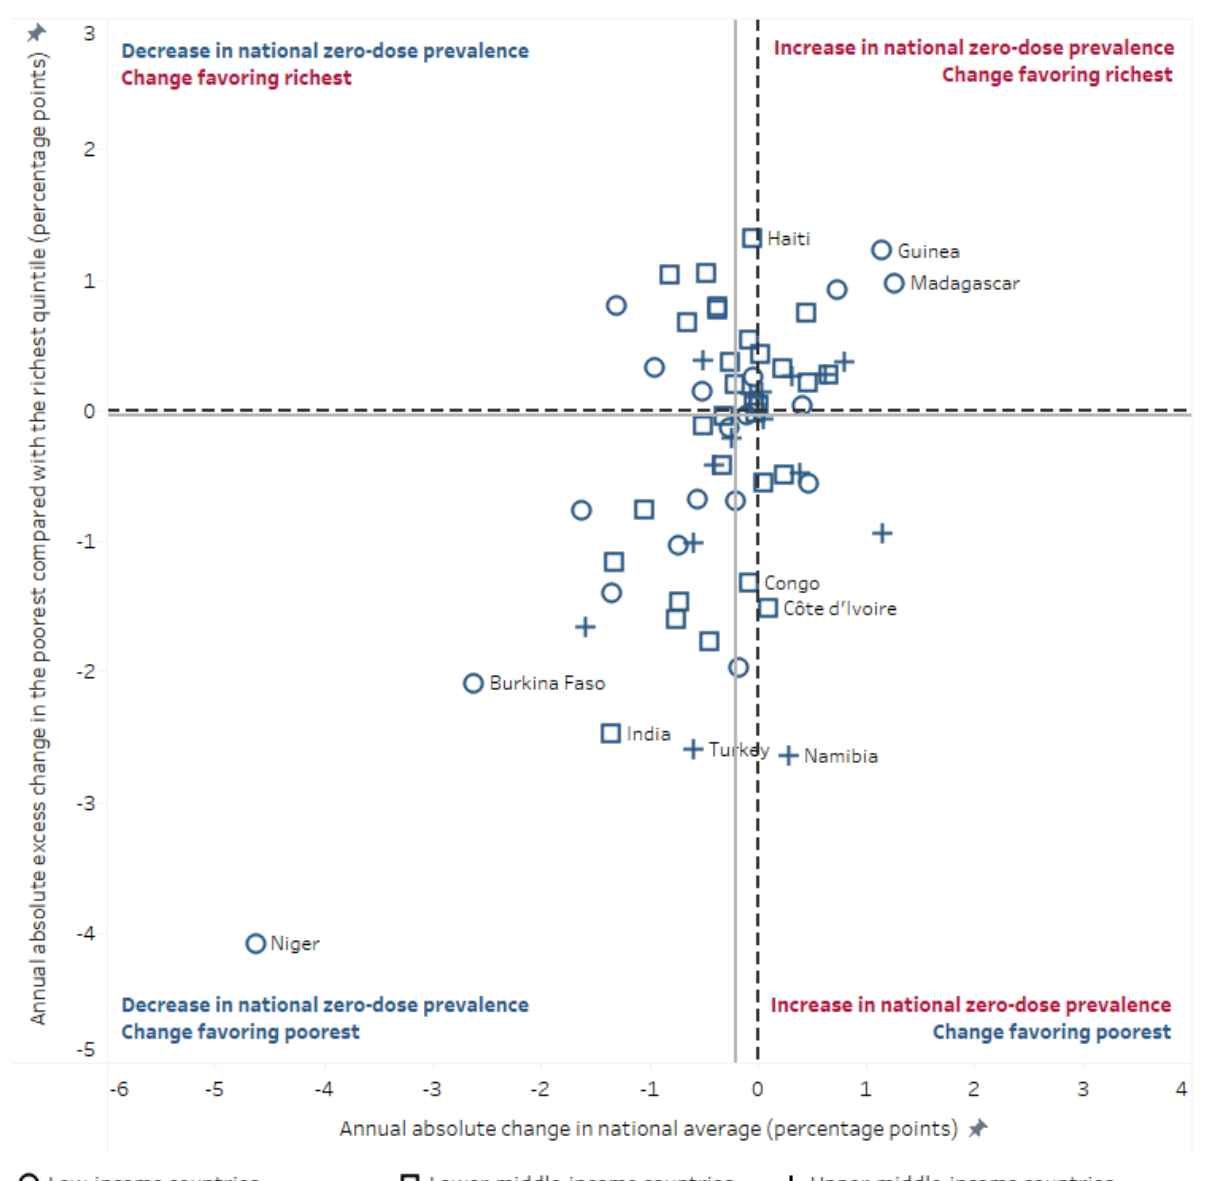
19 of 24 Overall, changes in inequality and national average over time demonstrated different patterns across countries (Figure 2). Several countries showed the most desirable trend: decreased national zero-dose DTP prevalence, with larger improvements among the poor- est households. Fourteen countries had a statistically significant decrease in absolute an- nual excess change. Most markedly, in Niger, the national zero-dose DTP prevalence de- creased by 4.6 percentage points per year between 2006 and 2012, with much more reduc- tion among the poorest quintile than the richest (absolute annual excess decline of 4.1 per- centage points). Similarly, Burkina Faso, India, and Turkey decreased their national zero-